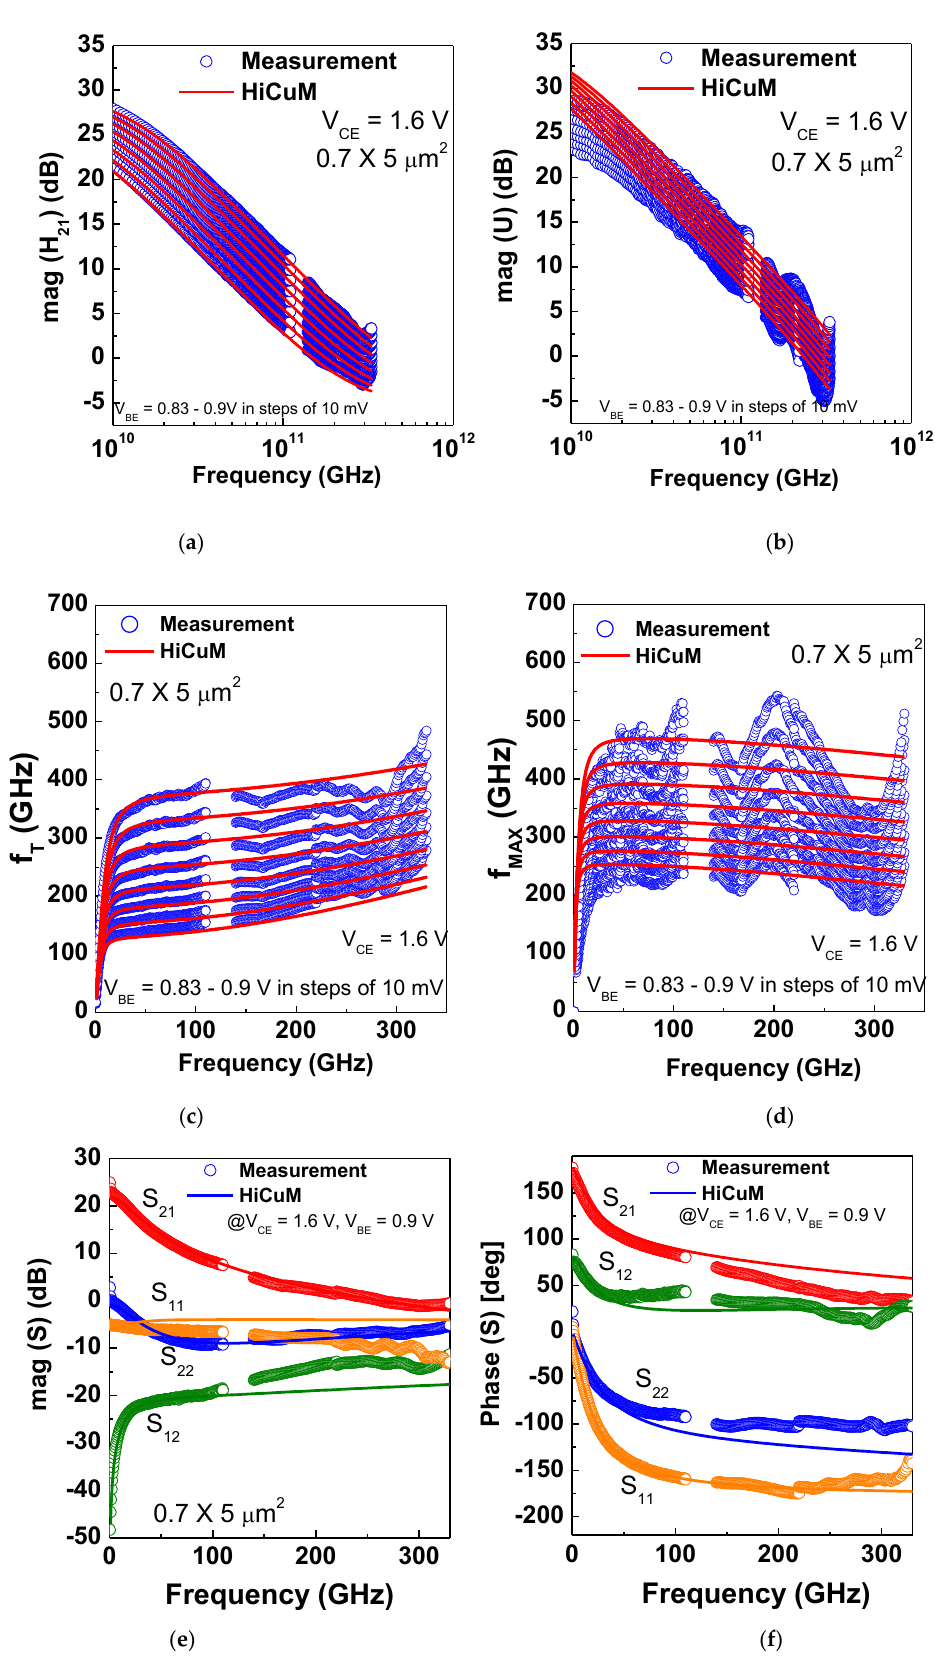
Figure 14. Comparison between HiCuM extrapolation and measurements up to 330 GHz: ( a , b ) gain curves, ( c , d ) cut-off frequencies and ( e , f ) S-parameters at peak f T .